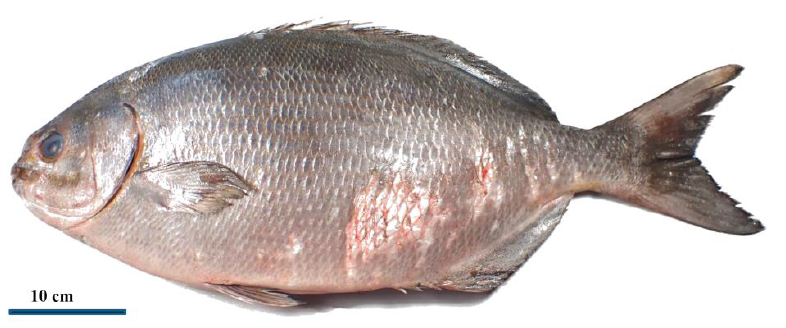
Figure 1. Kyphosus vaigiensis MHN USC-25201-4, 580 mm TL caught in Galician waters. Nine COI sequences from K. vaigiensis individuals caught in waters off Galicia (NW of Spain) were aligned with others retrieved from BOLD and GenBank to generate a set of 42 sequences, which were represented by 10 haplotypes. The median-joining network based on 616 nucleotide fragments does not suggest separation between the sampling sites (Figure 2). The most frequent haplotype ( N = 27 sequences) is common to all geo- graphical locations, including the north-western waters of the Iberian Peninsula, with the exception of Haiti and Malta, whose two sequences are associated with the second most common haplotype ( N = 6 sequences). Figure 2. Haplotype network of COI sequences of Kyphosus vaigiensis ( N = 42). Median-joining net- work (ε = 0) created in PopART v1.7. Each circle represents a haplotype; the size of circles corre- sponds to the number of individuals with the haplotype. Colours indicate sampling sites. Bars indi- cate the number of mutations between two haplotypes. The samples from Spain are of Atlantic origin (Galicia), and those from the United States come from Hawaii. The remaining historical records for the area of study are compiled in Table 2 accord- ing to the ichthyological literature. This dataset includes 26 records, of which 21 are from the Mediterranean. By species, 11 specimens of K. sectatrix and 10 of K. vaigiensis were reported in the Mediterranean area by only four and one, respectively, in the Atlantic. Sizes ranged from 195 to 610 mm TL for K. sectatrix and from 157 to 531 mm TL for K.